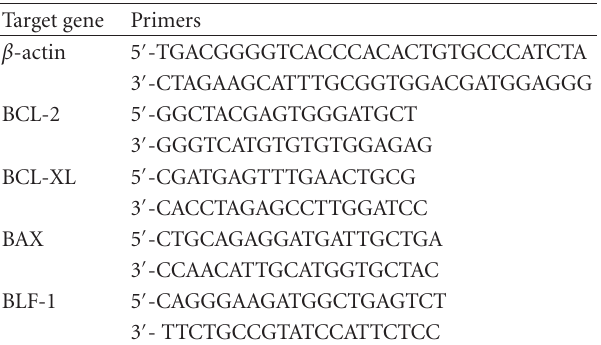
Table 2: Target gene